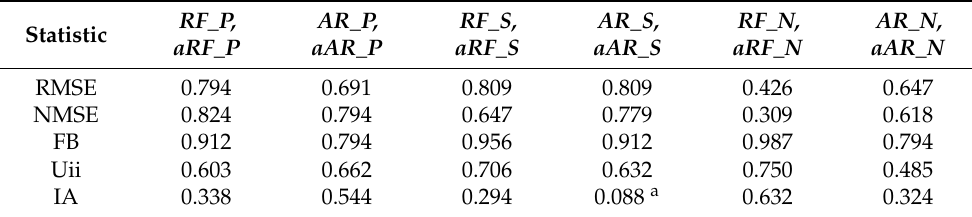
Table 7. Kendall’s correlations for comparison of the forecast accuracy of single and averaging models for 17 period steps, each one for a prediction horizon of h = 10 steps